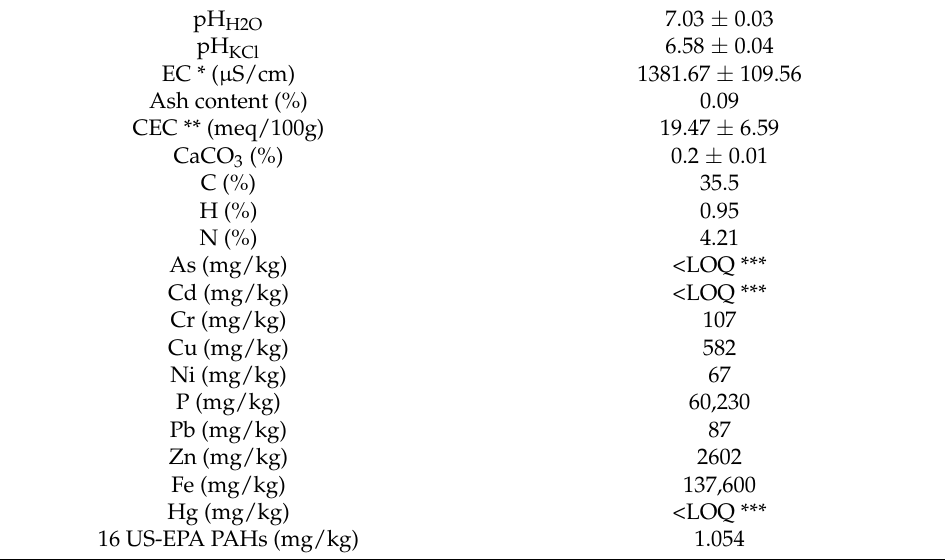
Table 1. Physico-chemical characteristics of pyrolyzed material